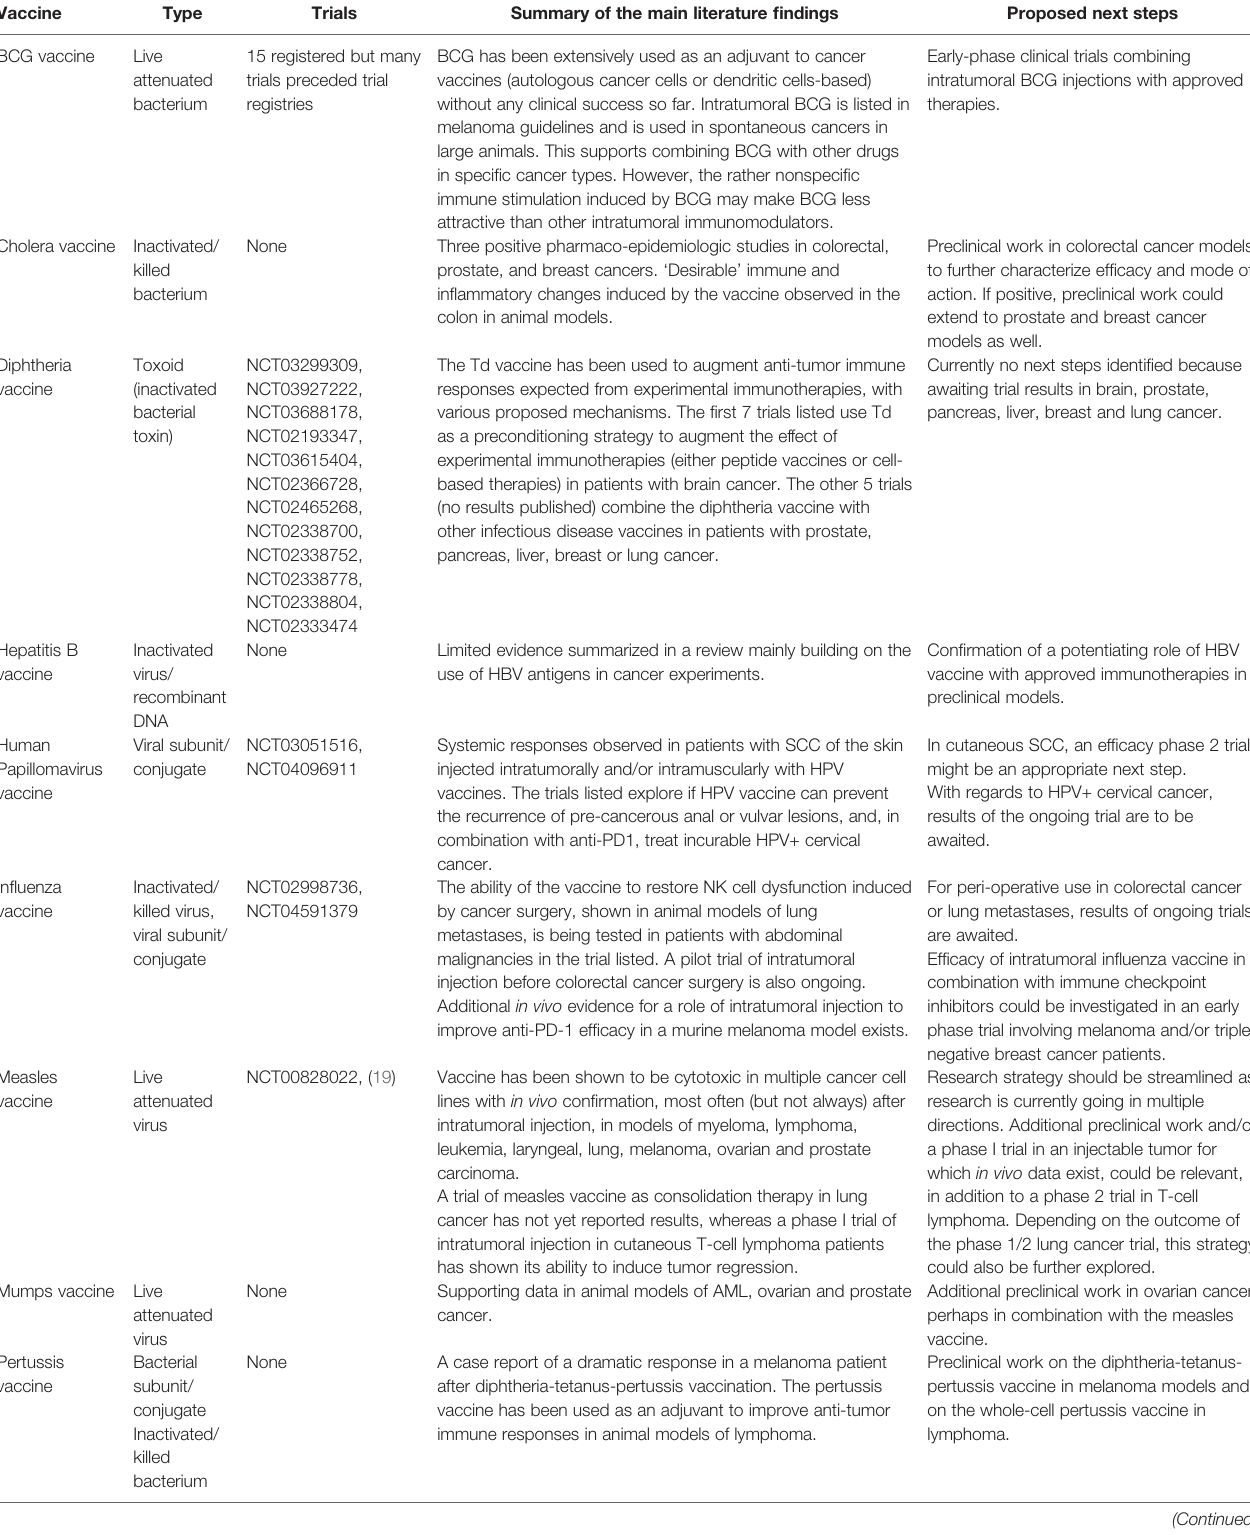
TABLE 2 | Overview of literature fi ndings and proposed next steps for vaccines with repurposing potential in oncology.